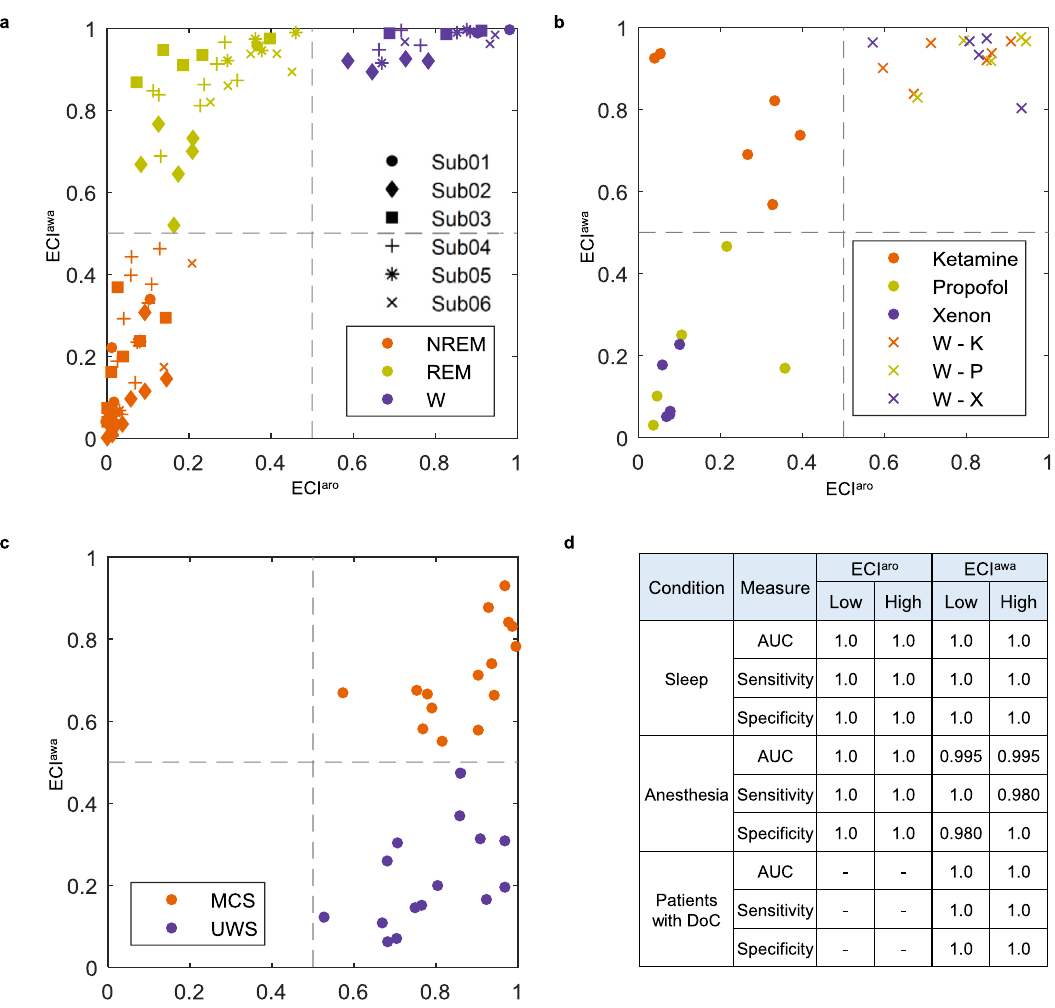
Fig. 2 Characteristics of ECI in TMS – EEG. In ECI, the symbols show the average ECI value of each transcranial magnetic stimulation (TMS) session, and the gray dashed lines indicate the optimal cutoff (0.5) dividing the space into high and low states of ECI. a In sleep and normal wakefulness, we depicted P01 – P06 by circles, diamonds, squares, plus signs, asterisks, and cross signs, respectively. Orange indicates NREM sleep with no subjective experience; copper indicates REM sleep with subjective experience (i.e., dreaming); moreover, purple indicates normal wakefulness. b In anesthesia and wakefulness before anesthesia, the orange, copper, and purple dots indicate the use of ketamine, propofol, and xenon, respectively. In addition, cross markers indicate normal wakefulness before each anesthetic. c In patients with disorders of consciousness, the orange and purple dots indicate patients in the minimally conscious state (MCS) and with unresponsive wakefulness syndrome (UWS), respectively. d In each condition, the classi fi cation performance for ECI aro and ECI awa was measured. W normal wakefulness; W – K = healthy wakefulness before ketamine; W – P = healthy wakefulness before propofol; W – X = healthy wakefulness before